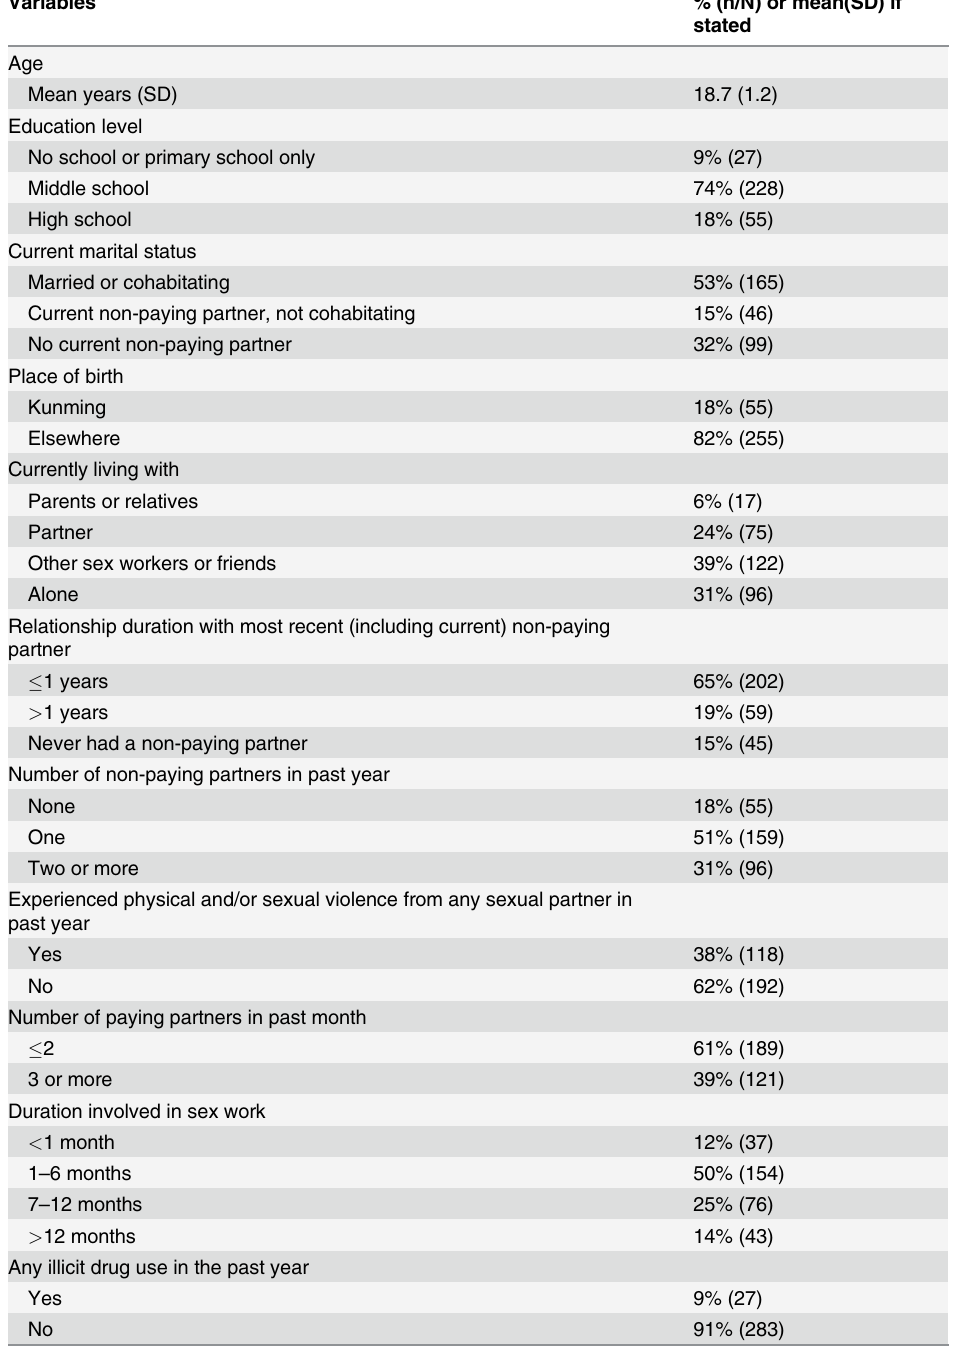
Table 2. Socio-demographic characteristics and sex work characteristics of adolescent sex worker (N =